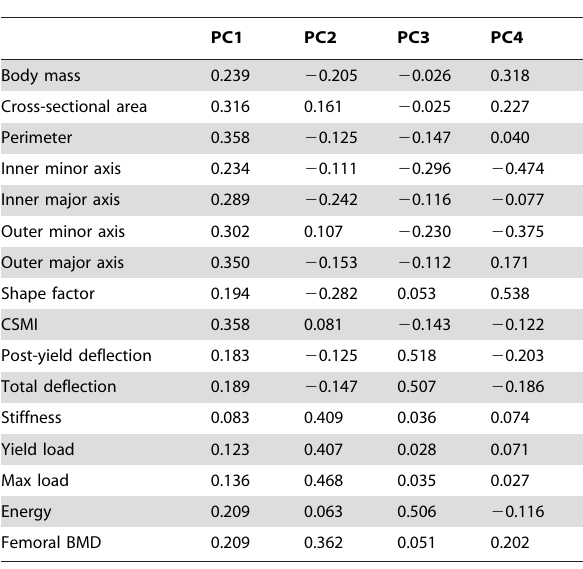
Table 7. Eigenvectors of Principal Components